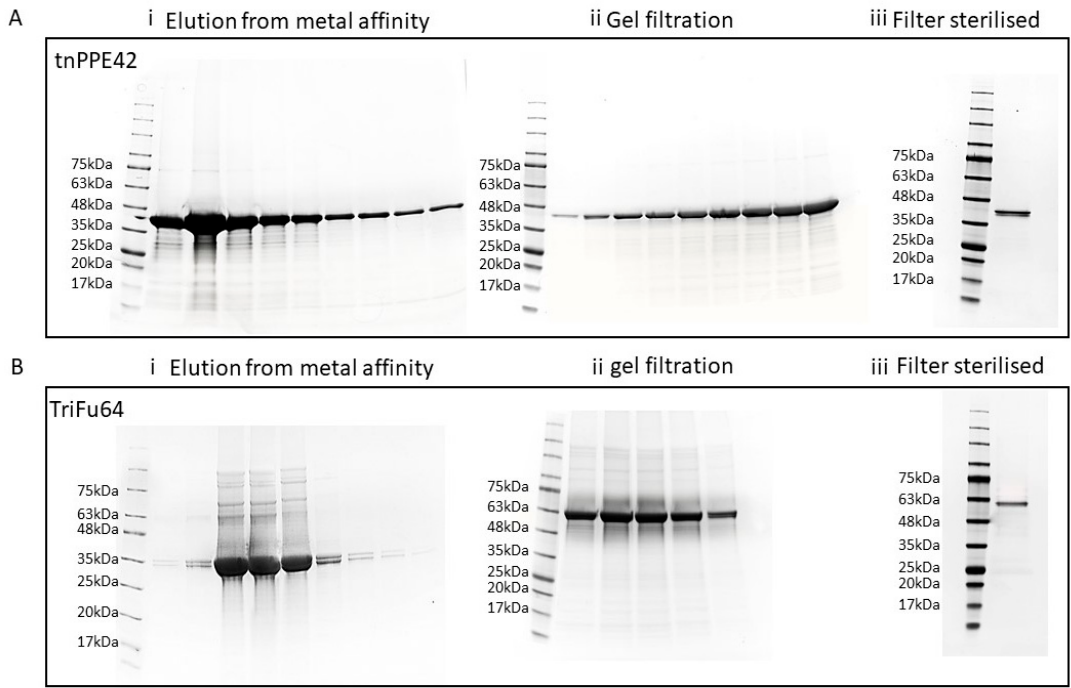
Figure 2. Purification and sterilization of protein preparations. ( A ) The soluble and pellet fractions from the induced E. coli cultures containing the tnPPE42 plasmid, and were filter sterilized ready for use in vivo. ( B ) The protein profile for each fraction is shown using 4–20% SDS-PAGE electrophoresis.